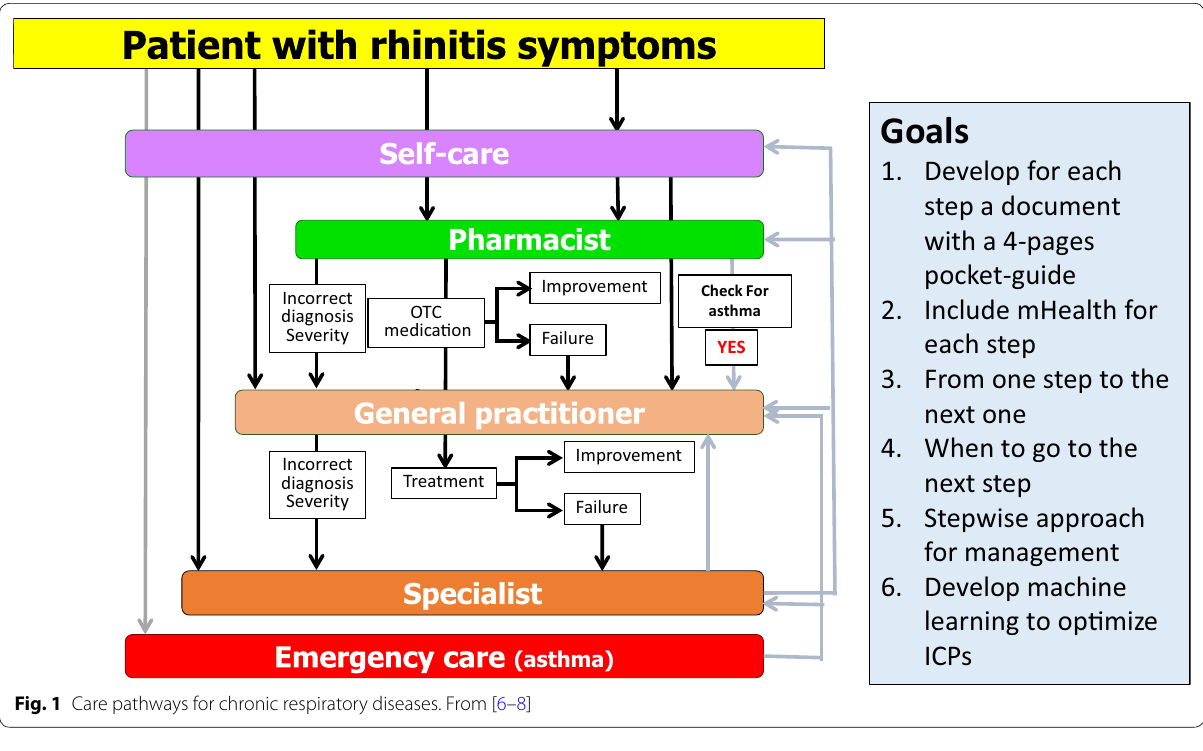
Fig. 1 Care pathways for chronic respiratory diseases. From [6–8]